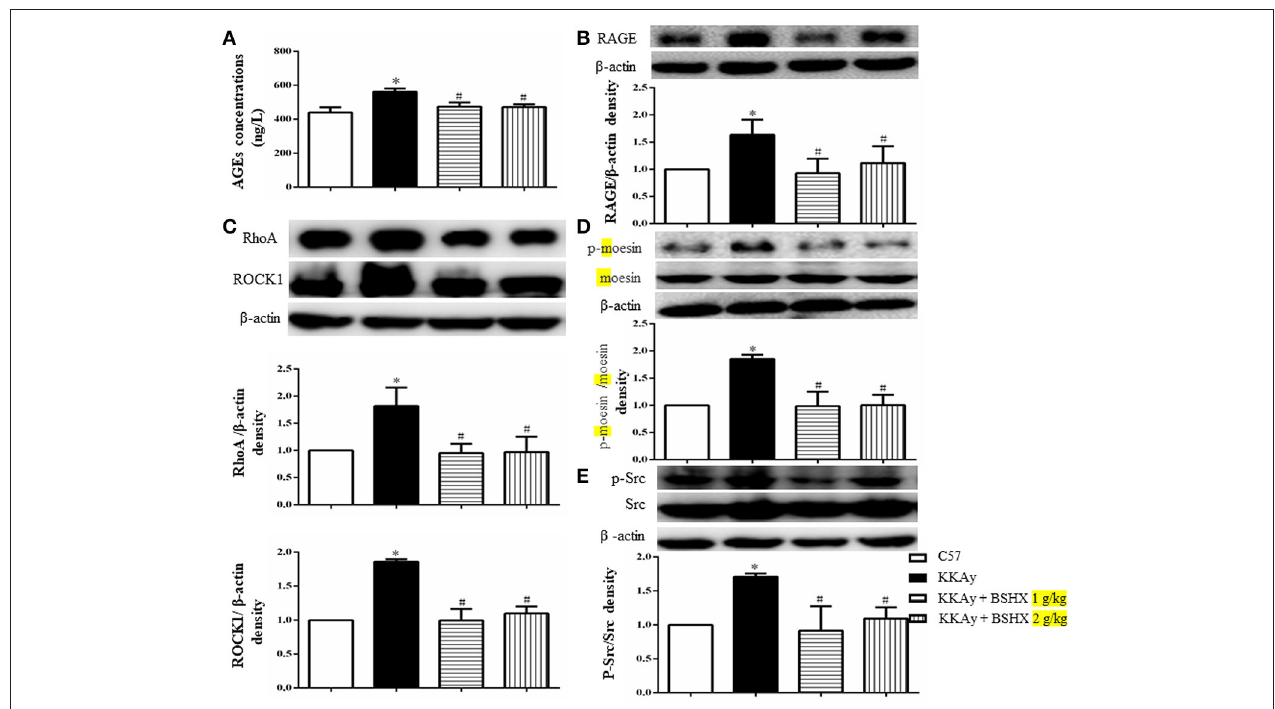
FIGURE 10 | The effect of BSHX on the expression levels of AGE, RAGE, RhoA, ROCK1, p-Mosein and Src phosphorylation. (A) Level of AGEs. (B) Representative western blots and quantitative analysis of RAGE in various groups. (C) Representative western blots and quantitative analysis of RhoA, ROCK1 in various groups. (D) Representative western blots and quantitative analysis of moesin and p-moesin in various groups. (E) Representative western blots and quantitative analysis of Src and p-Src in various groups. Data were expressed as mean ± SD ( n = 6). * p < 0.05 vs. C57 group, # p < 0.05 vs. KKAy